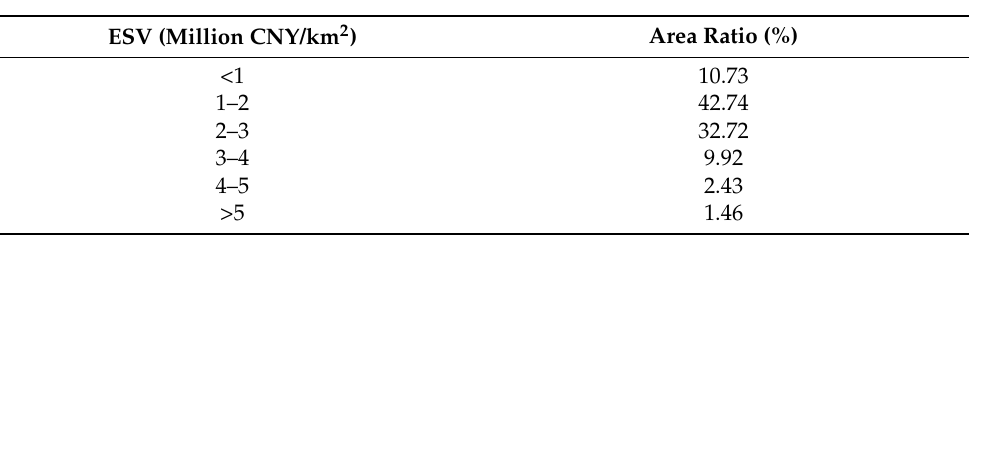
Table 4. Area ratio of average grassland ESV in Inner Mongolia from 2000 to